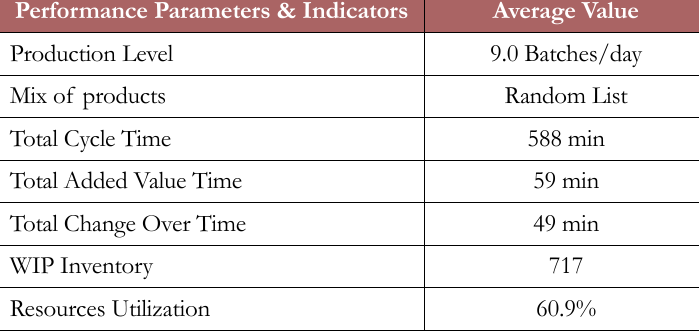
Table 8. Manufacturing Performances of CELLMFG